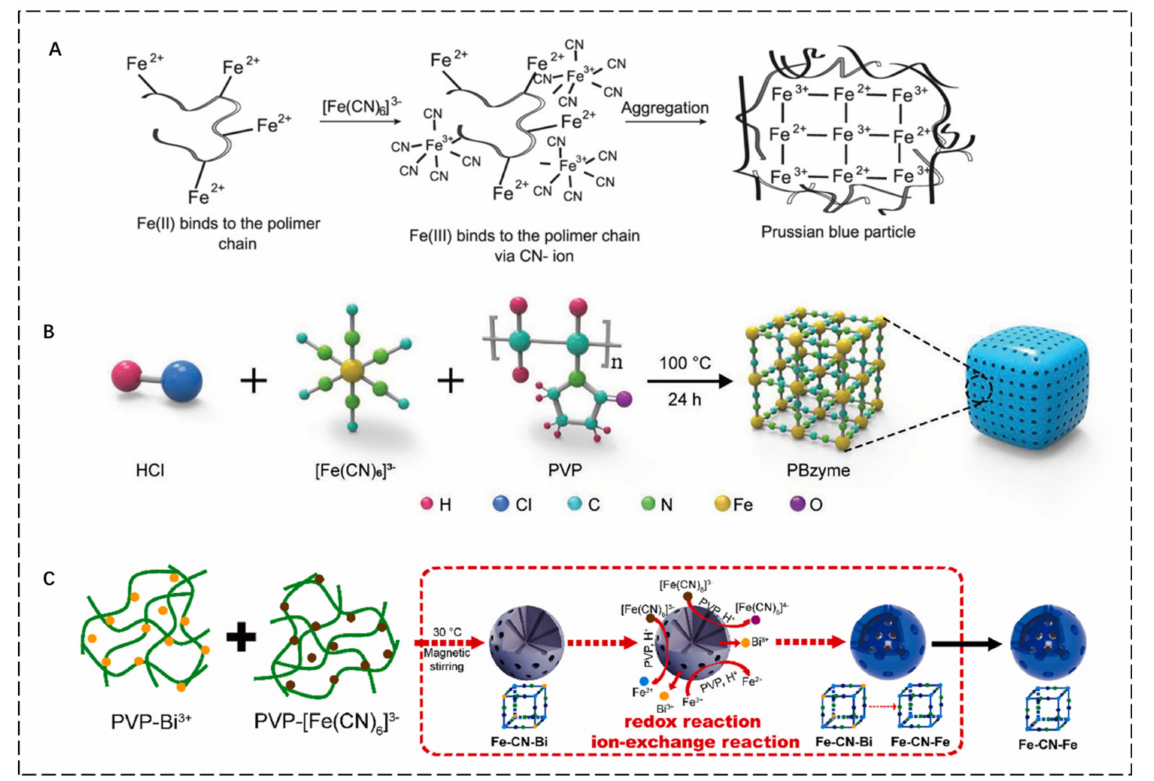
Figure 2. ( A ): Schematics of formation of the PVP − protected PBNPs [25]. ( B ): Schematics of the PBzyme synthesis process [26]. ( C ): Schematics of the synthesis of HPBzyme [27]. Copyright application has been